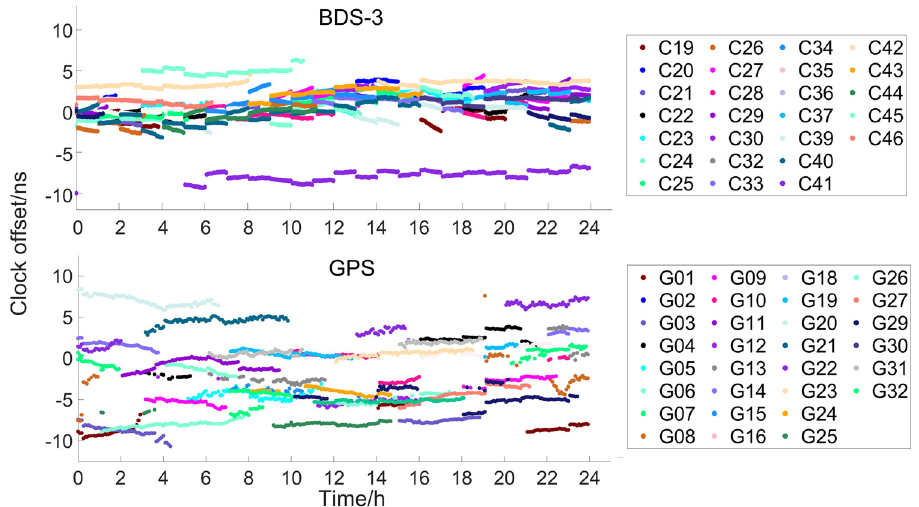
Figure 6. Re-edit of the time series of the clock corrections of the BDS-3 and the GPS satellites on DOY 192 in 2022.